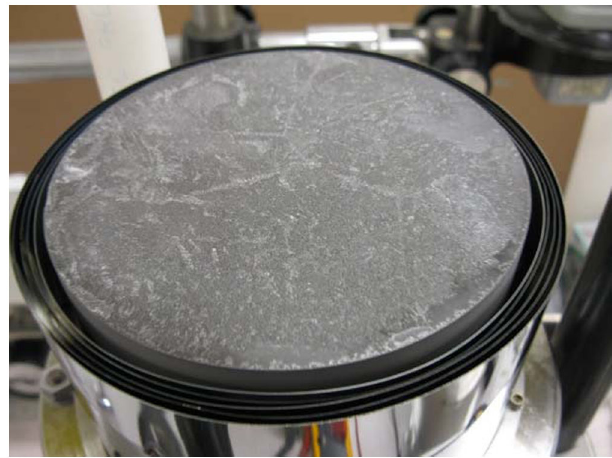
FIG. 1. The emitter, aluminosilicate coated on a porous tung- sten substrate, is shown in the heat-shield assembly, prior to ion beam